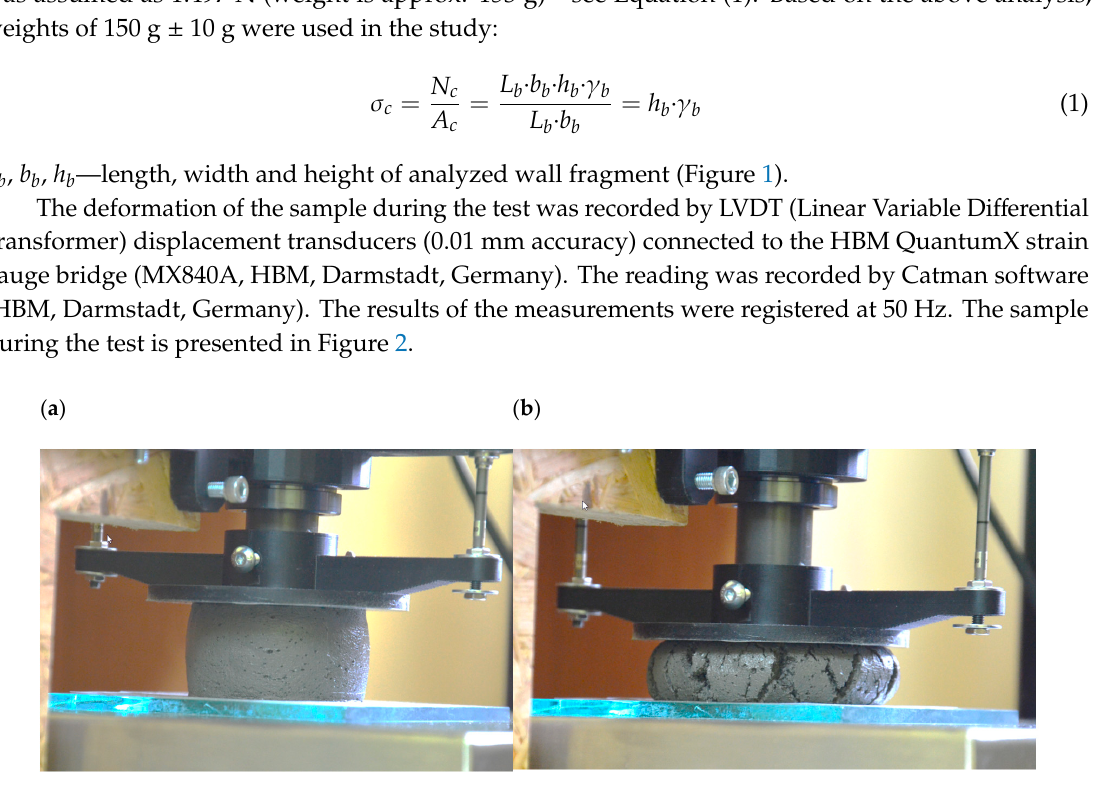
Figure 2. Sample during the squeezing test: ( a ) first stage of test (small load); ( b ) end of test (the specimen failure).